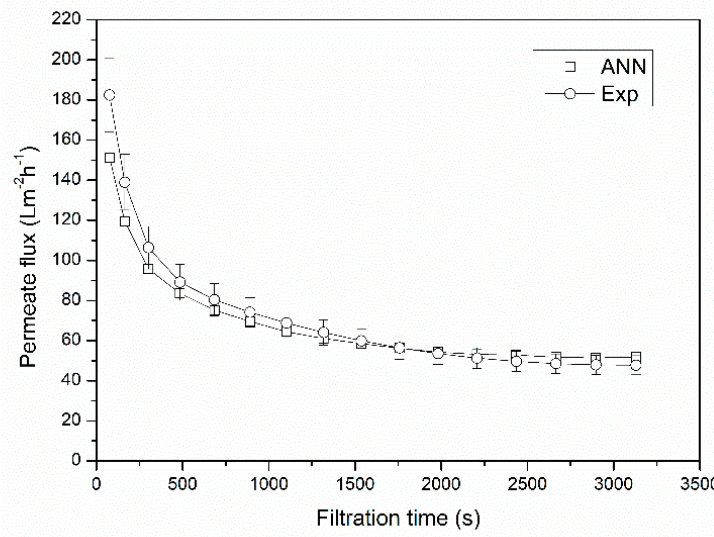
Figure 4. Generalization capacity of the ANN model.